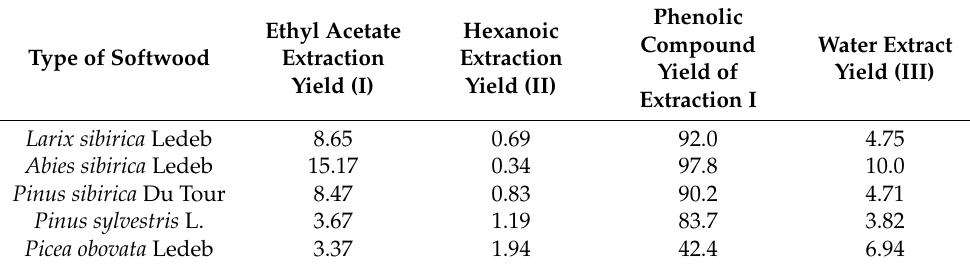
Table 3. Yield of softwood bark extractive substances, % a.d.m.